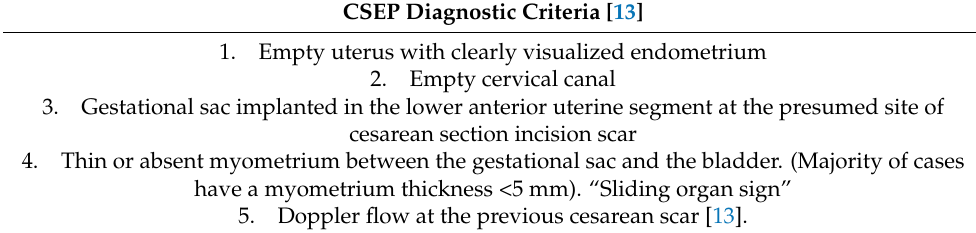
Table 1. Diagnostic